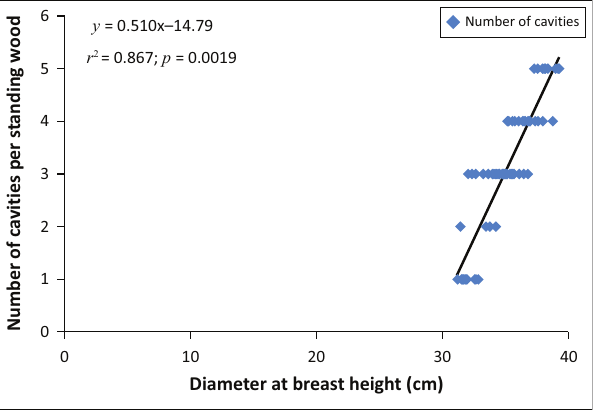
FIGURE 2: Correlates between number of cavities per standing wood and diameter at breast height in the study areas of Chimfushi and Mwekera forests, Zambia, in 2014.